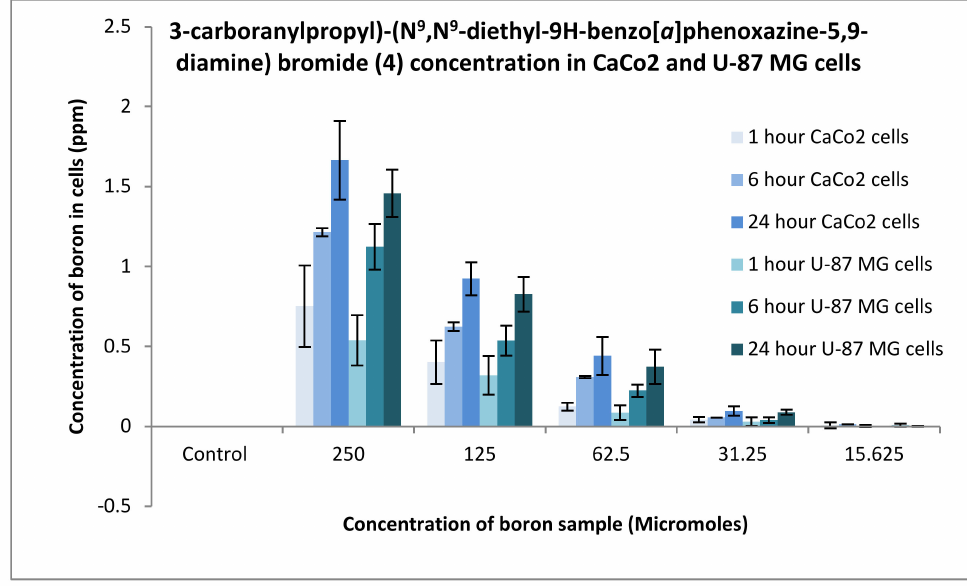
Figure 17. Uptake of boron for 3-carboranylpropyl)-(N 9 ,N 9 -diethyl-9H-benzo[ a ]phenoxazine-5,9- diamine) bromide (4) into CaCo2 and U87 MG cells after 1, 6 and 24